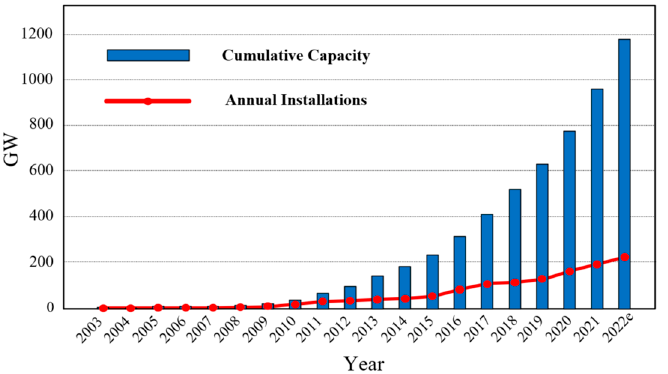
Figure 1. Cumulative and annual PV installations from 2003 to 2021 with an estimate for 2022.